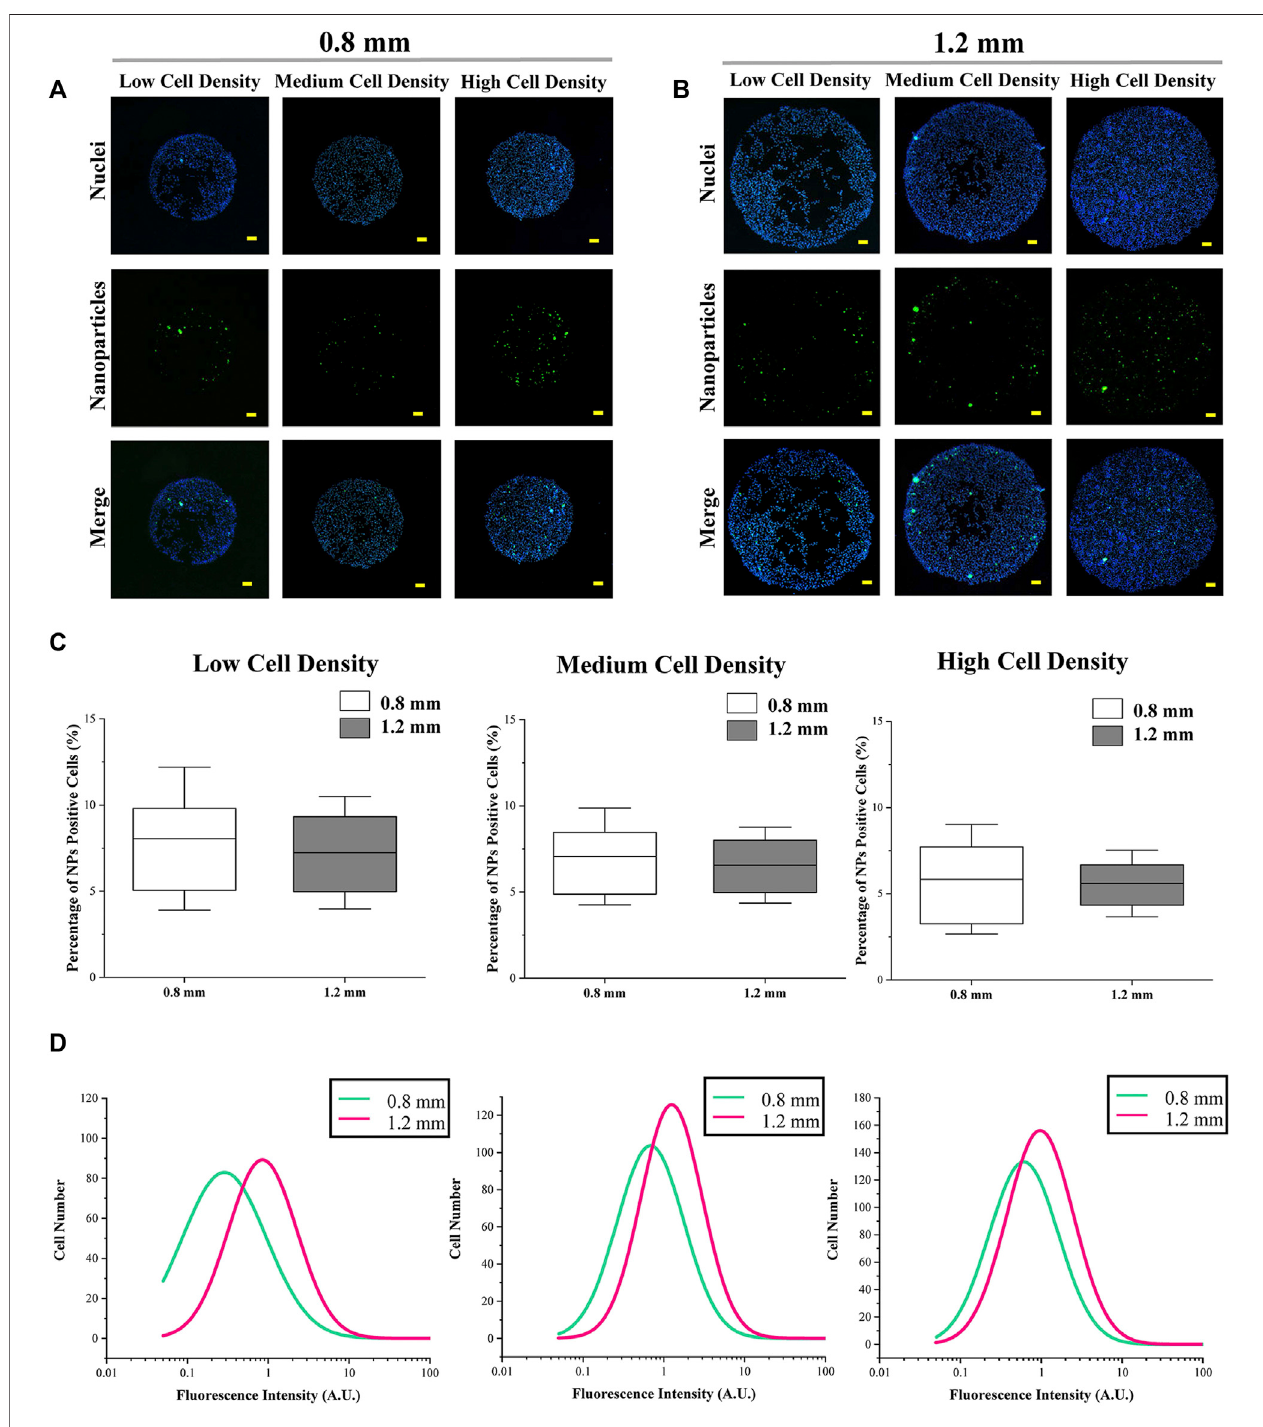
FIGURE 3 | Cellular uptakecapacity of micropatterned colonies with different sizes. (A,B) Representative images of fl uorescent NPs and nuclei. Scale bar: 50 μ m. (C) Percentage of NP-positive cells. Data are presented as means ± SDs ( n > 30). (D) Fluorescence intensity of NP-positive cells ( n > 3,000).